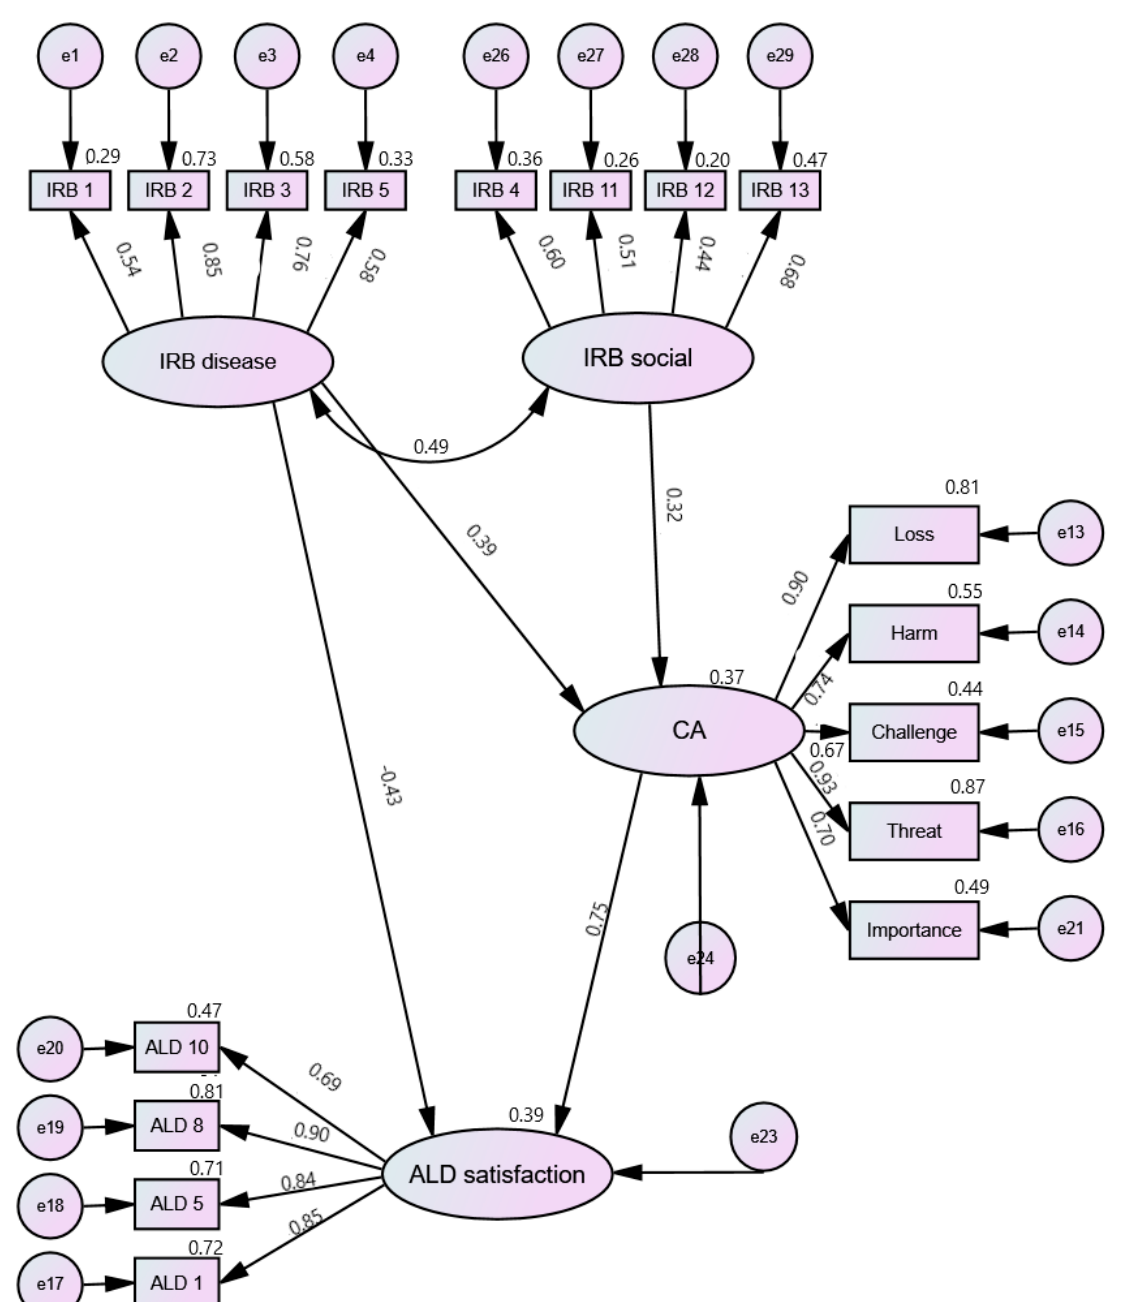
Figure 2. Cognitive factors and ALD Satisfaction: Path diagram. IRB—Illness-related Beliefs; CA— Cognitive Appraisal; ALD—Acceptance of Living with the Disease.